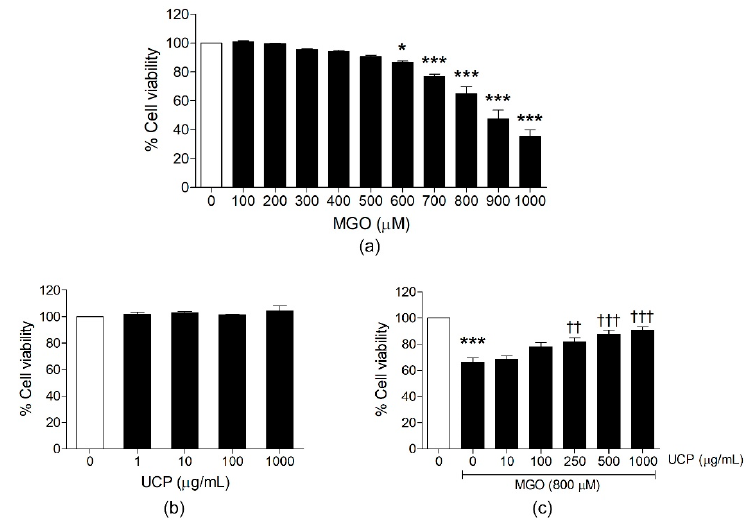
Figure 1. The protective effect of UCP on MGO-induced EA hy926 cell death. MTT assay was used